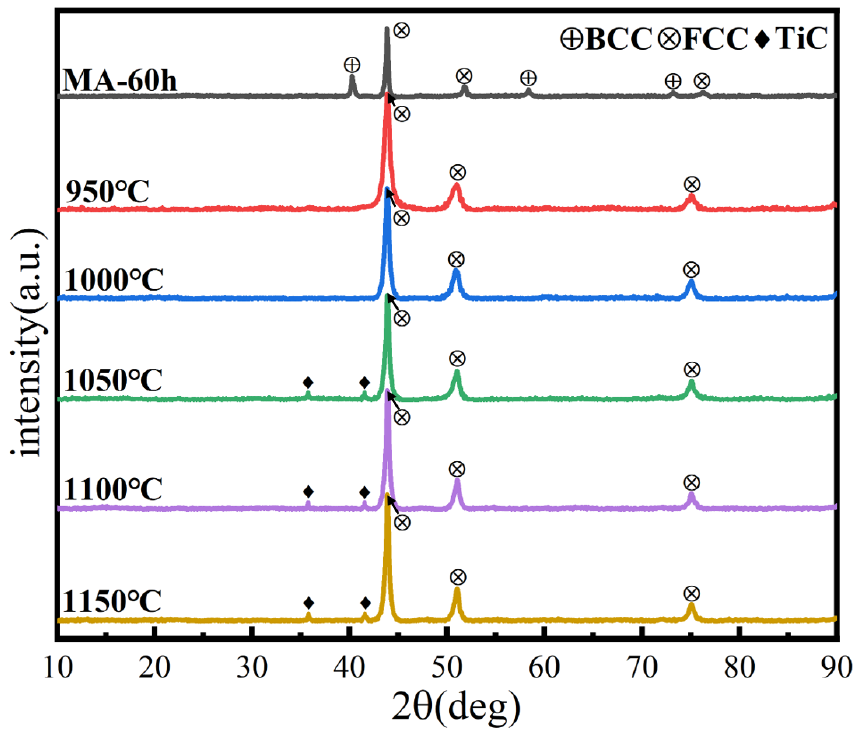
Figure 12. XRD patterns of the HEA blocks at different sintering temperatures.